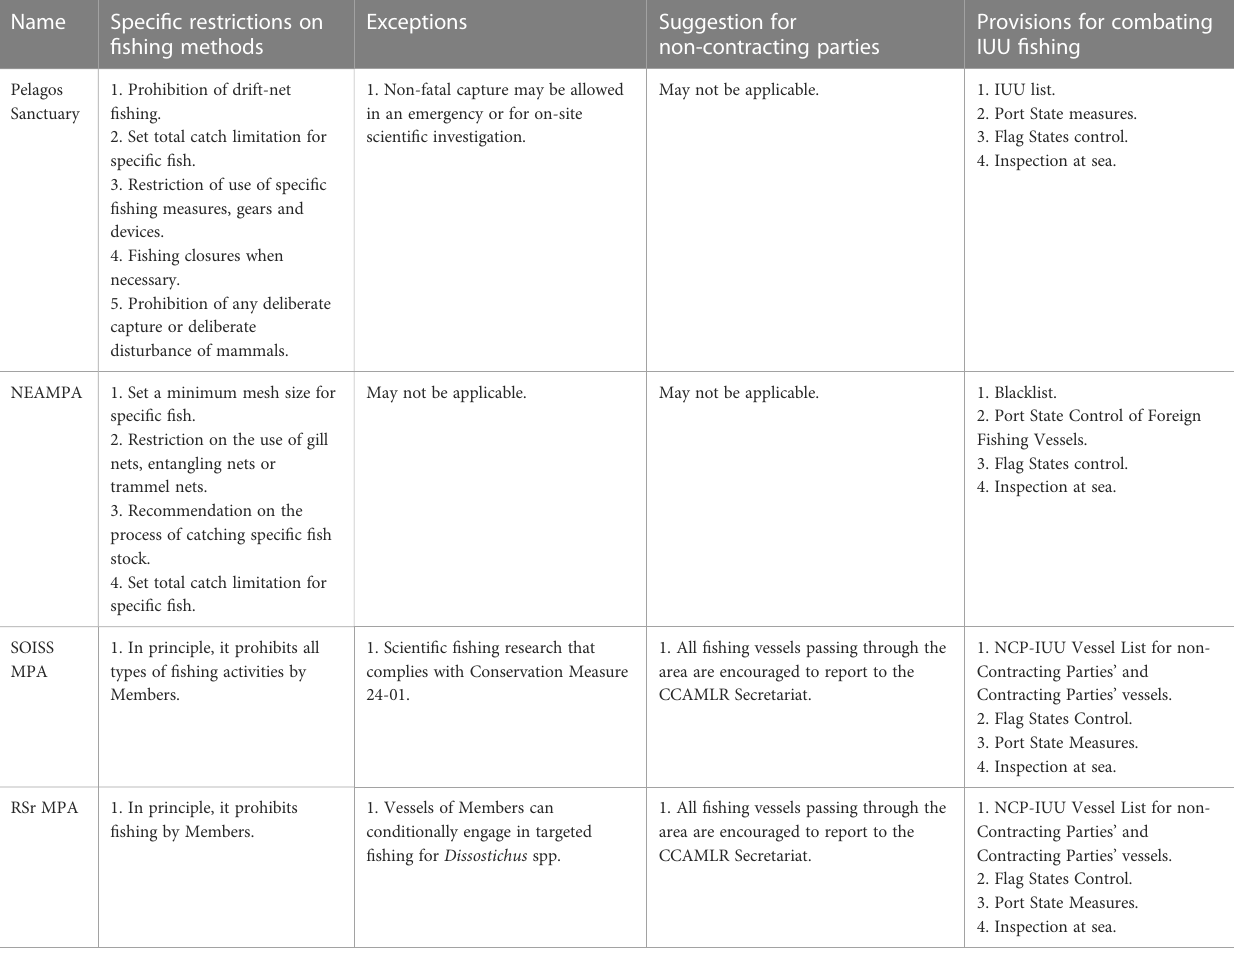
TABLE 3 Reasonable fi shing-restriction measures in the four high seas